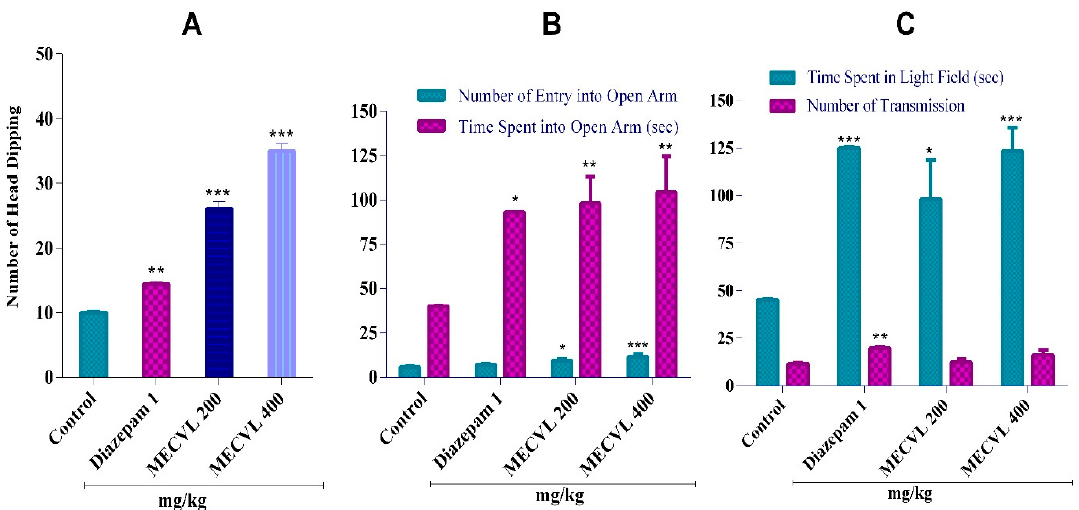
Figure 3. Effect of MECVL and diazepam in the hole board test ( A ), elevated plus maze test ( B ), and light / dark exploration test ( C ) in mice, respectively. Each value is presented as the mean ± SEM (n = 5). * p < 0.05, ** p < 0.01, and *** p < 0.001 compared with the control group (Dunnett’s test); MECVL: Methanolic extract of Chukrasia velutina leaves.